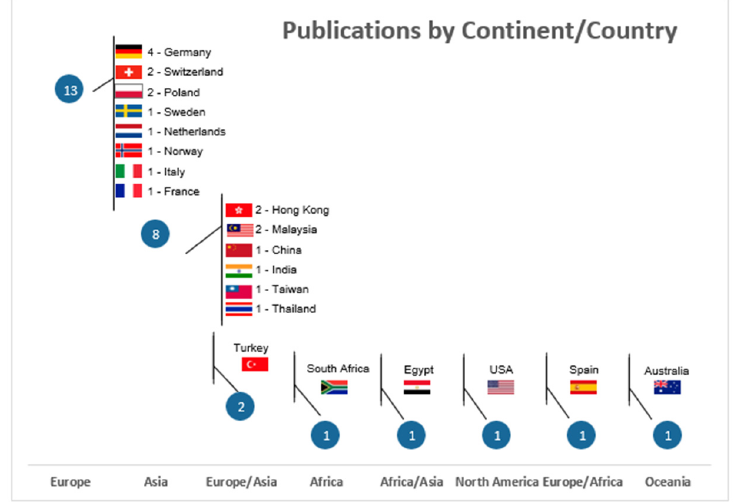
Figure 4. Number of publications by country.